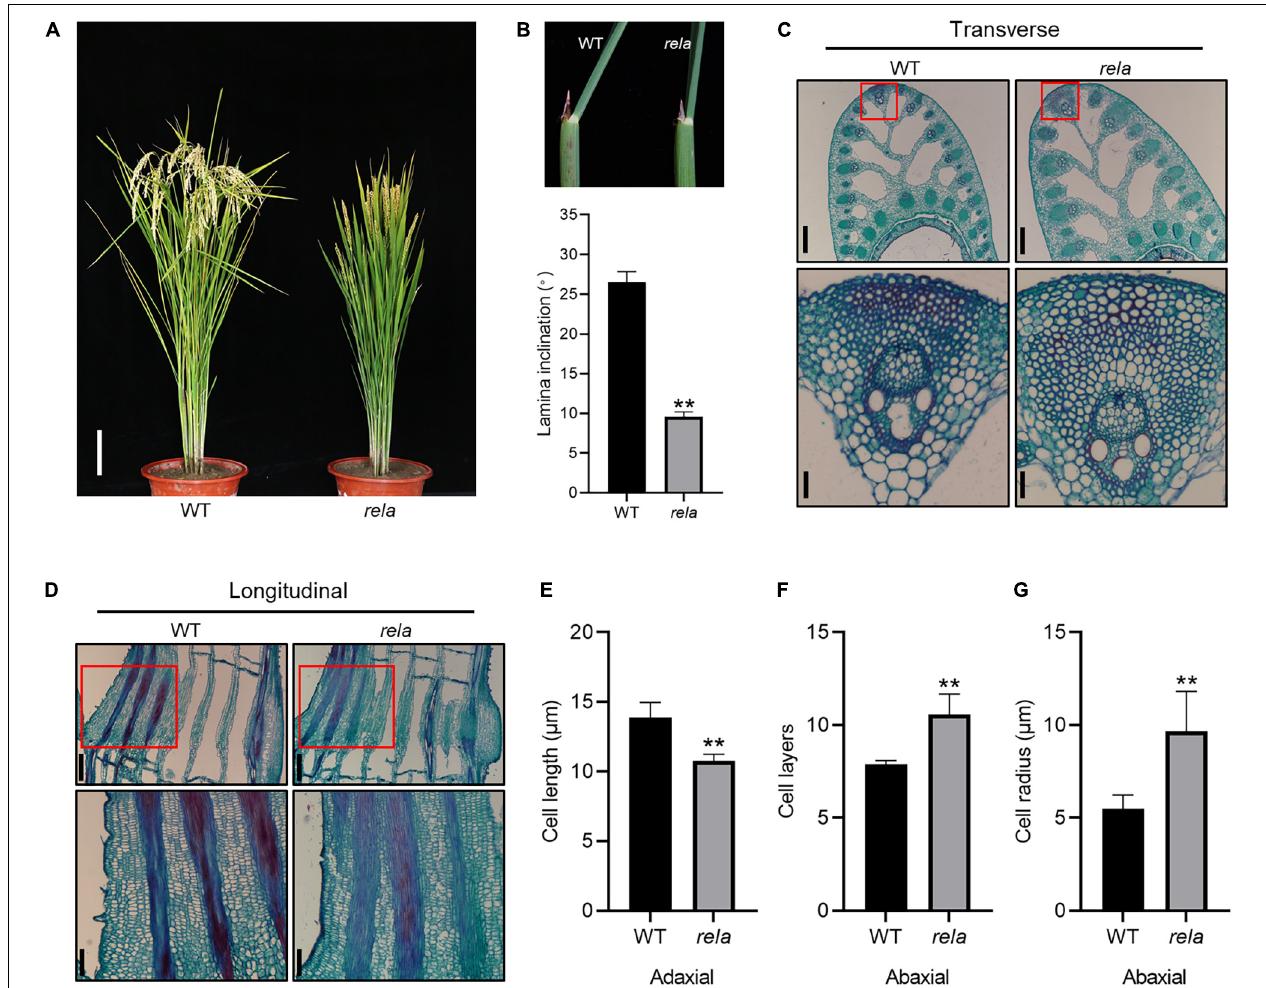
FIGURE 1 | Phenotypic characterization of the rela mutant. (A) The morphological phenotypes of the wild-type and rela at the grain-filling stage. Bar = 20 cm. WT, wild-type. (B) Quantification of the leaf inclination of the second lamina joint of wild-type and rela . The picture at top shows the second lamina joints. Error bars are SD ( n = 30). Asterisks indicate significant differences from the WT (** P < 0.01, Student’s t -test). (C) Transverse section of the lamina joints of wild-type and rela . The red box indicates the enlarged abaxial sides of the lamina joint. Bars = 250 µ m in the upper panel and 30 µ m in the lower panel. (D) Longitudinal section of the lamina joints of wild-type and rela . The red box indicates the enlarged adaxial sides of the lamina joint. Bars = 250 µ m in the upper panel and 30 µ m in the lower panel. (E) Measurement of lamina joint adaxial cell lengths of wild-type and rela [shown in (D) ]. Error bars are SD ( n = 60). Asterisks indicate significant differences from the WT (** P < 0.01, Student’s t -test). (F) The number of sclerenchyma cell layers in the adaxial sides of wild-type and rela [shown in (C) ]. Error bars are SD ( n = 30). Asterisks indicate significant differences from the WT (** P < 0.01, Student’s t -test). (G) Measurement of sclerenchyma cell radius in the abaxial sides of wild-type and rela [shown in (C) ]. Error bars are SD ( n = 30). Asterisks indicate significant differences from the WT (** P < 0.01, Student’s t -test).